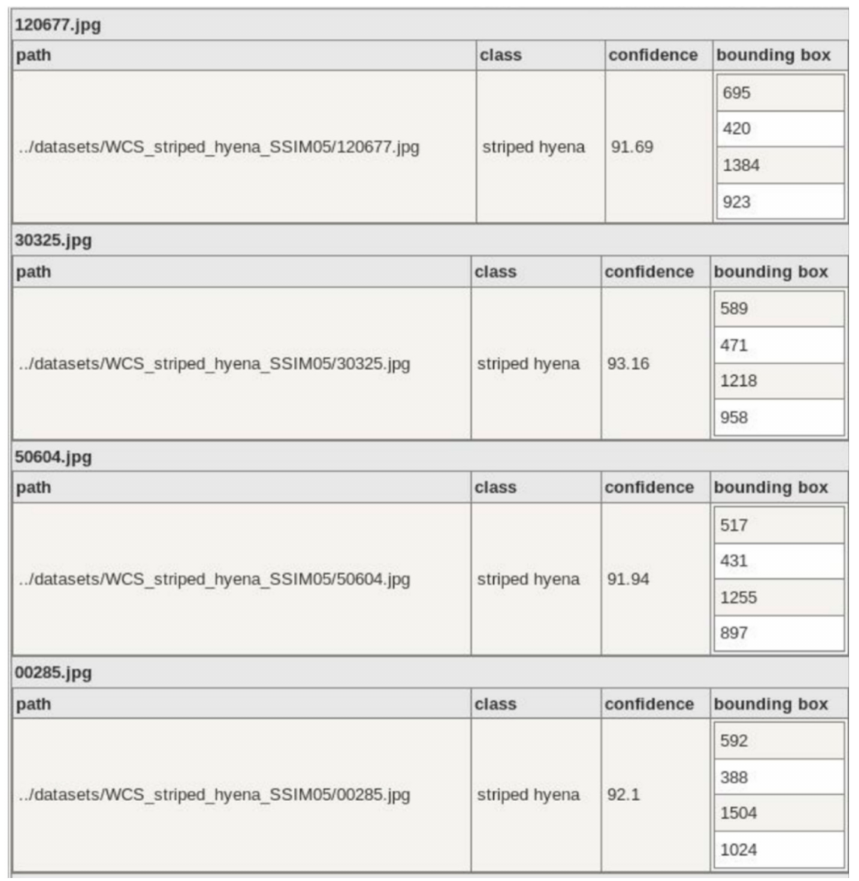
Figure 4. A sample of the detailed report, which shows per image data, including class label, classification confidence and bounding box data for each object. This preview is generated using